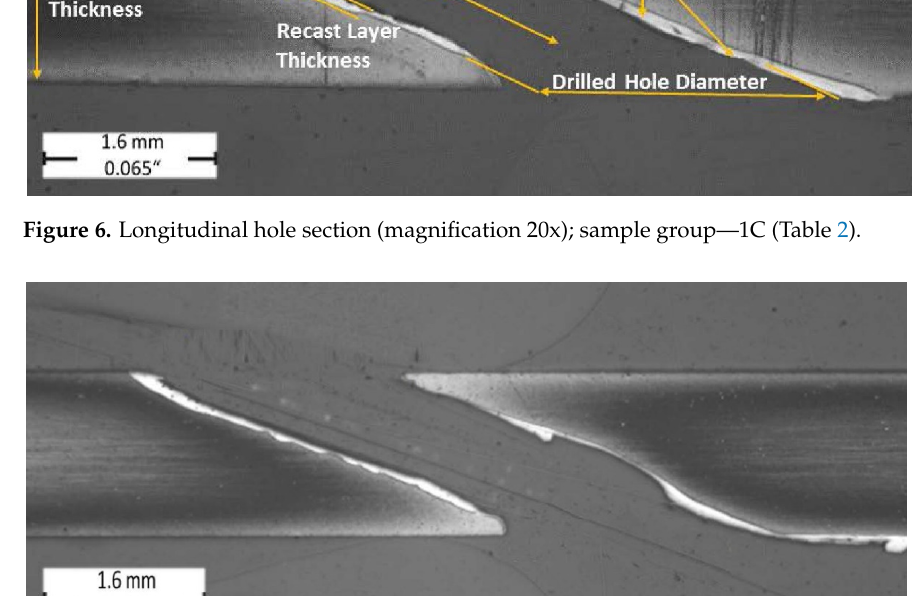
Materials 2021 , 14 , x FOR PEER REVIEW Figure 7. Longitudinal hole section (magnification 20x); sample group—2C (Table 2).